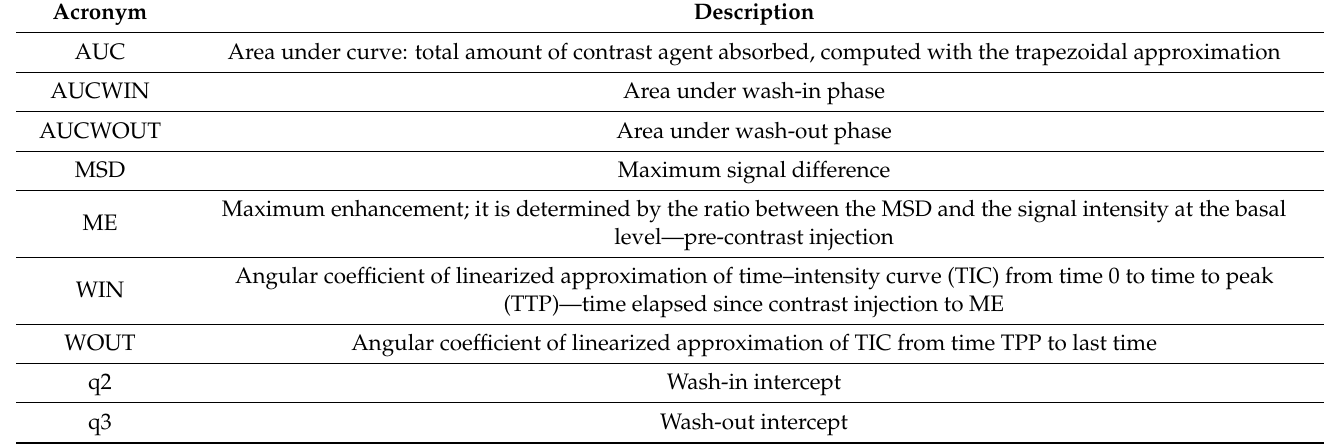
Table 3. Description of the dynamic